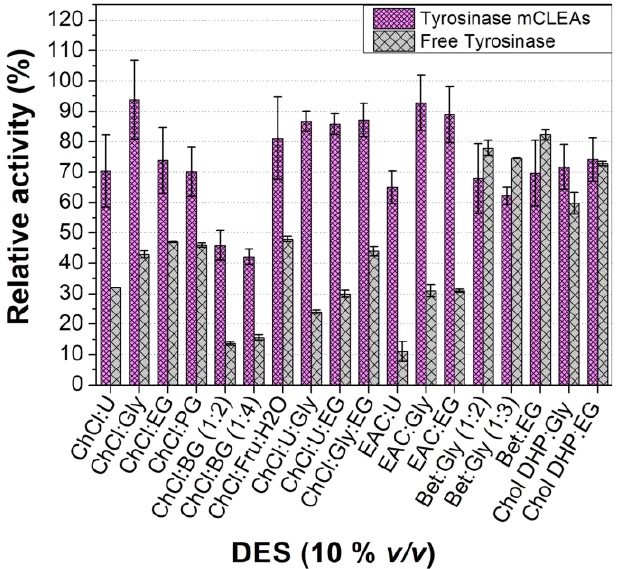
Figure 5. Relative activity of tyrosinase mCLEAs and free tyrosinase in 10% v / v aqueous solutions of certain DESs. 100% is defined as the activity of tyrosinase mCLEAs or free tyrosinase in DES-free solution.